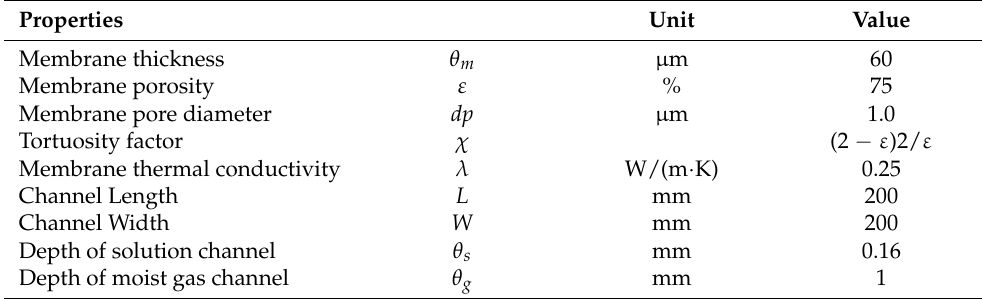
Table 2. Geometric parameters of the membrane